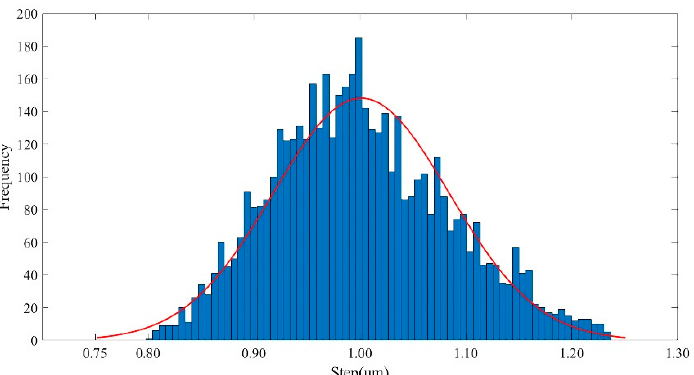
Table 2. The statistical analysis of neuron stretch device with a one- μ m step.